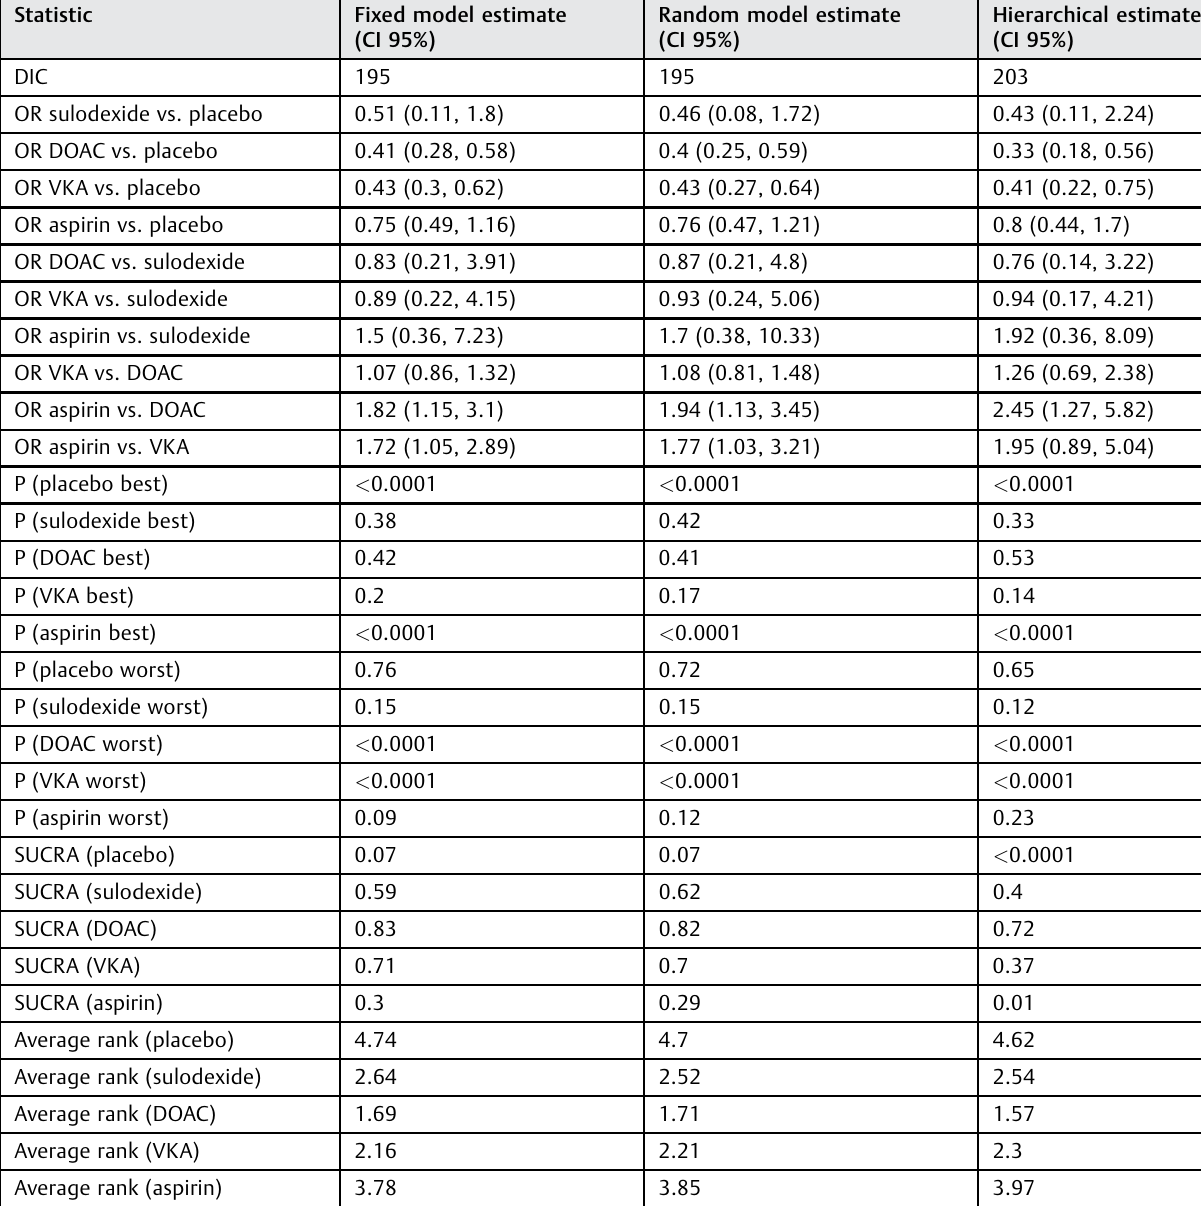
Table 2 Main results for PE, all studies